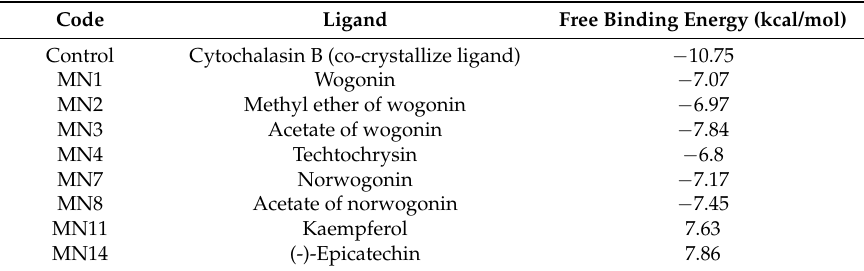
Table 1. Docking score of selected flavonoids against GLUT